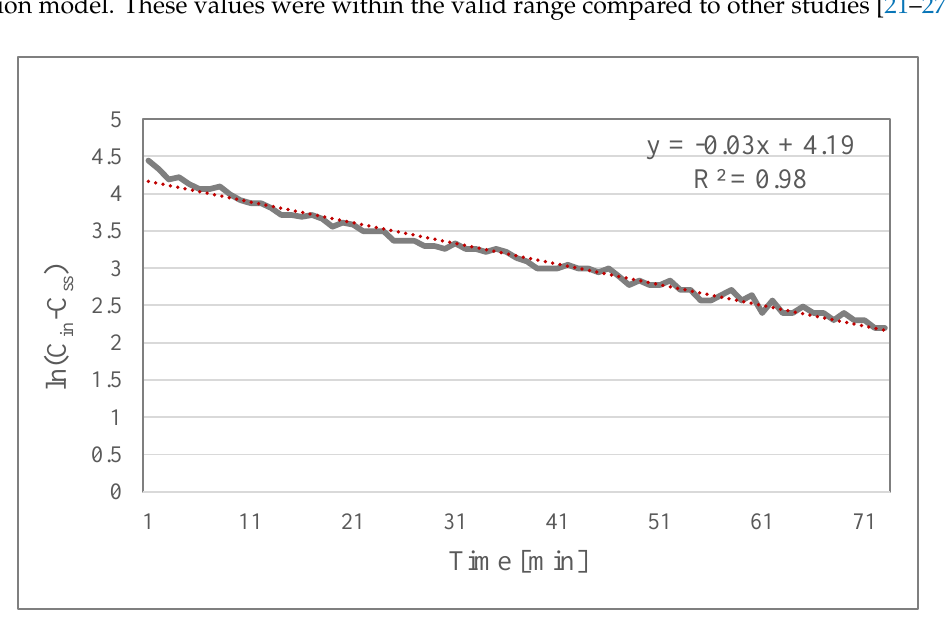
Figure 4. An example of indoor and outdoor PM2.5 concentration for estimating parameter P and k.